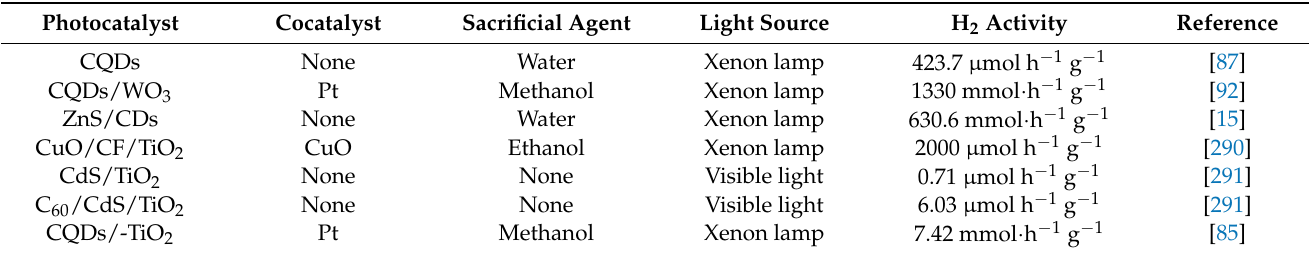
Table 7. H 2 production rate of carbon quantum dot-based